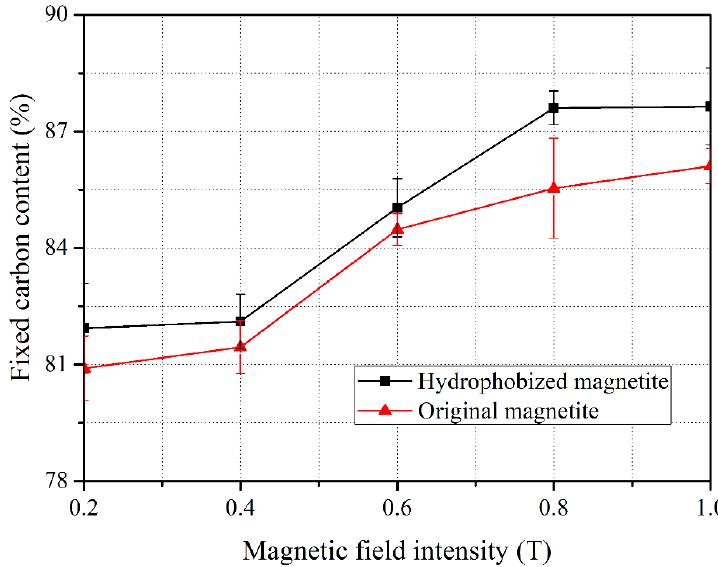
Figure 5. The fixed carbon content of microcrystalline graphite as a function of magnetic field intensity for different magnetic seeds. The error bars represent the standard deviation of multiple replicates.